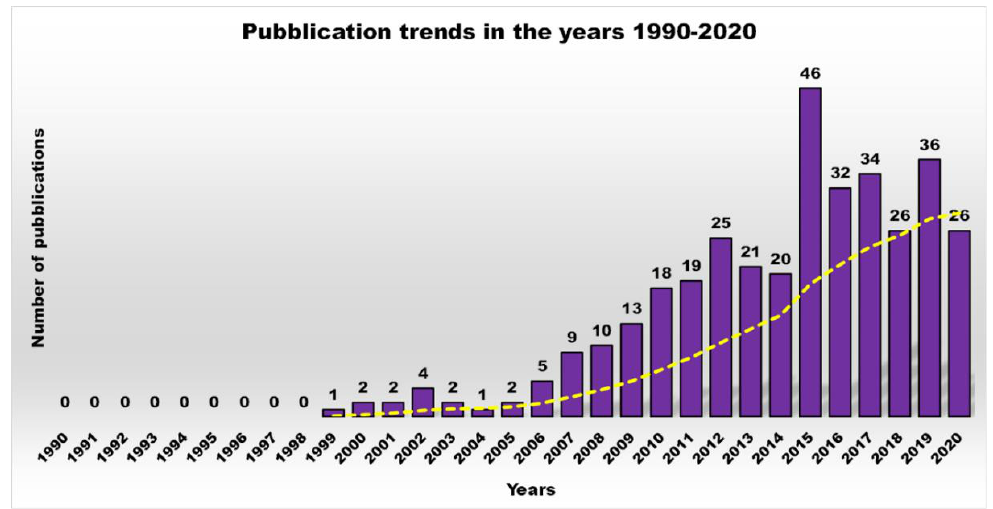
Figure 1. Number of publications as a function of time, obtained by typing the key words “antimicrobial dendrimers” in Scopus.